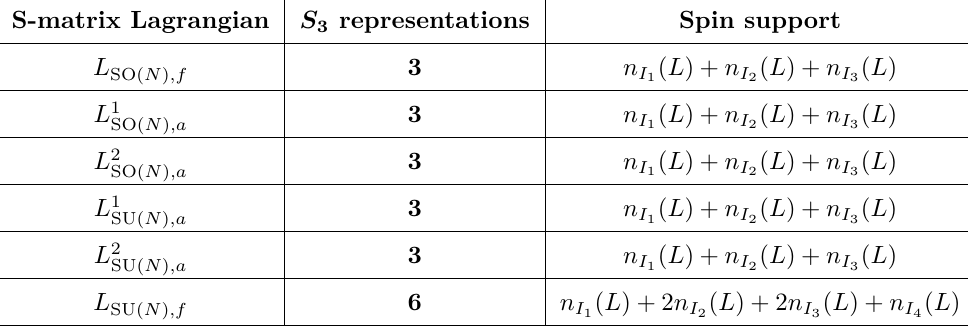
Table 4 . Spin support for scalar S-matrices.